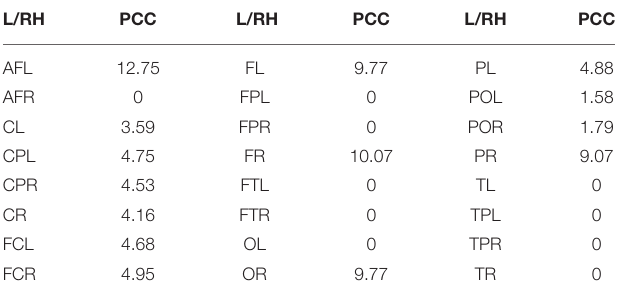
TABLE 3 | Inter-L/RH FC with PCC.